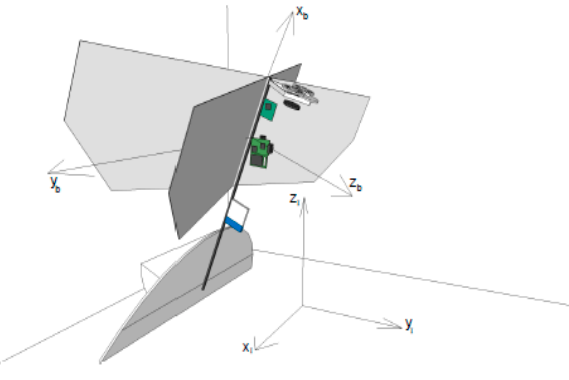
Figure 4. The DelFly II schematic diagram [93].